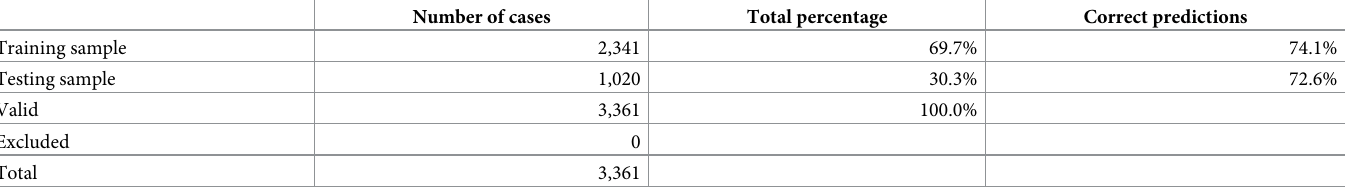
Table 4. ANN case processing summary–Model